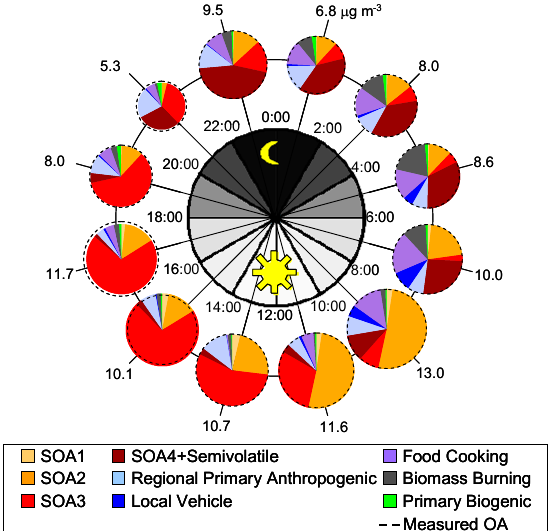
Fig. 16. Average diurnal concentrations of TAG-derived PMF fac- tors over the fall focus period. PM 1 organic aerosol mass concen- trations labeled outside of pie chart ring, and time of day labeled inside of pie chart